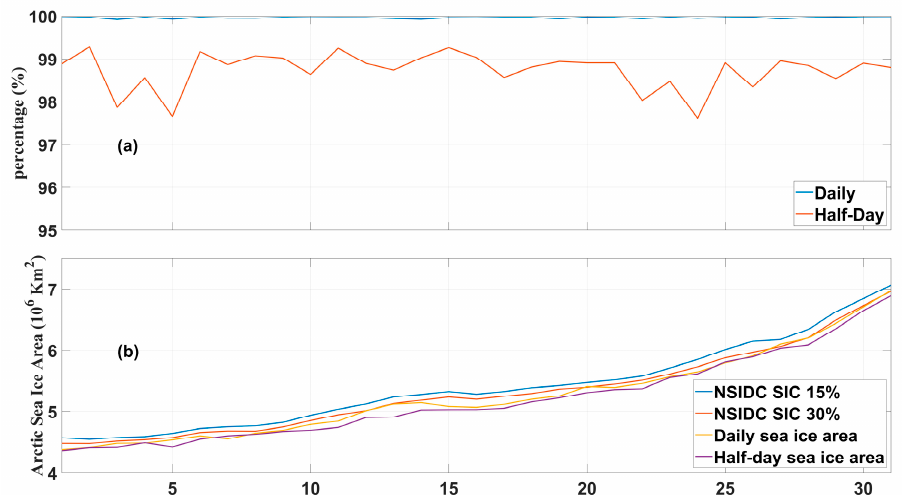
Figure 12. Comparison of acquisition of data at daily and half-day time intervals in the Artic for October 2020: ( a ) data coverage; ( b ) sea ice area.